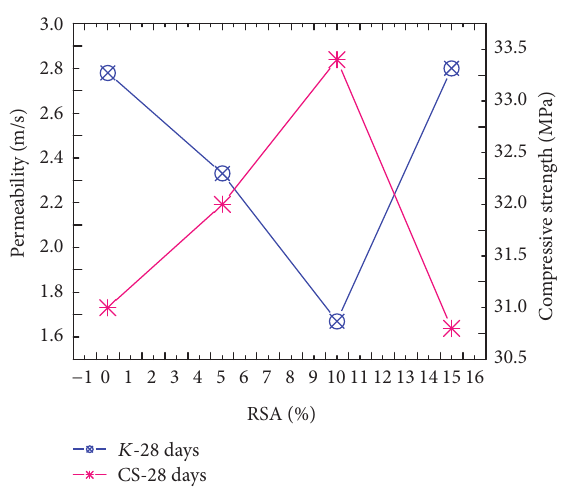
Figure 12: Relationship between K and CS at 28